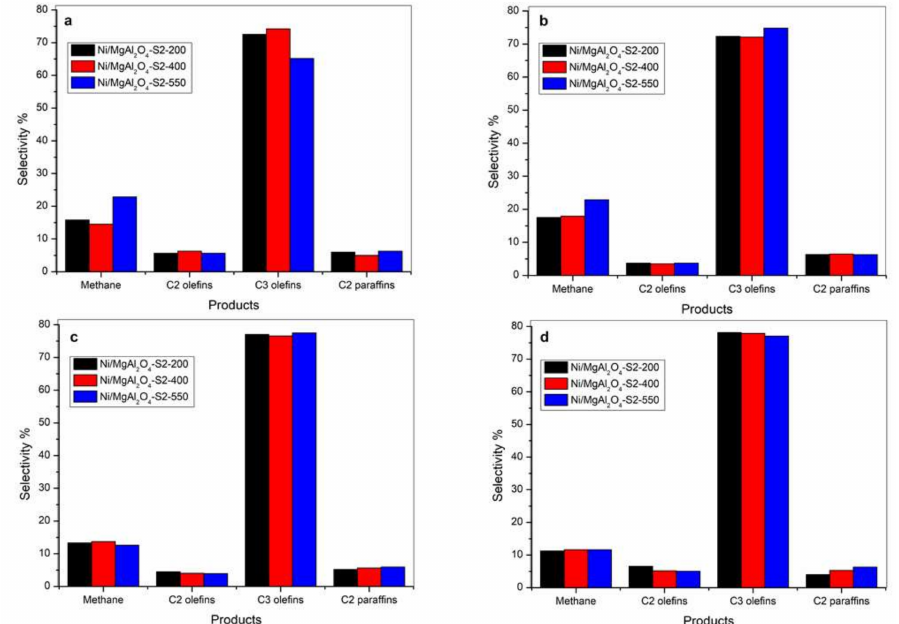
Figure 17. Selectivity % of Ni/MgAl 2 O 4 sulfided with (NH 4 ) 2 S at ( a ) 3 min, ( b ) 30 min, ( c ) 60 min, and ( d ) 120 min.